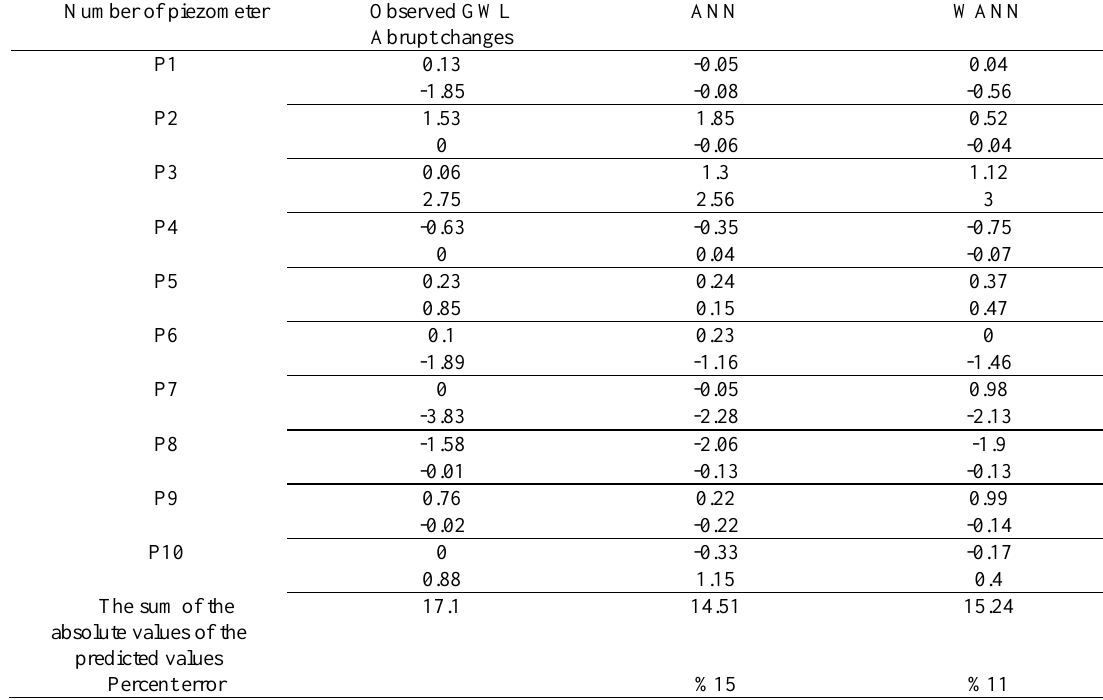
Table 8. Performance of models to forecast the peak of groundwater level.